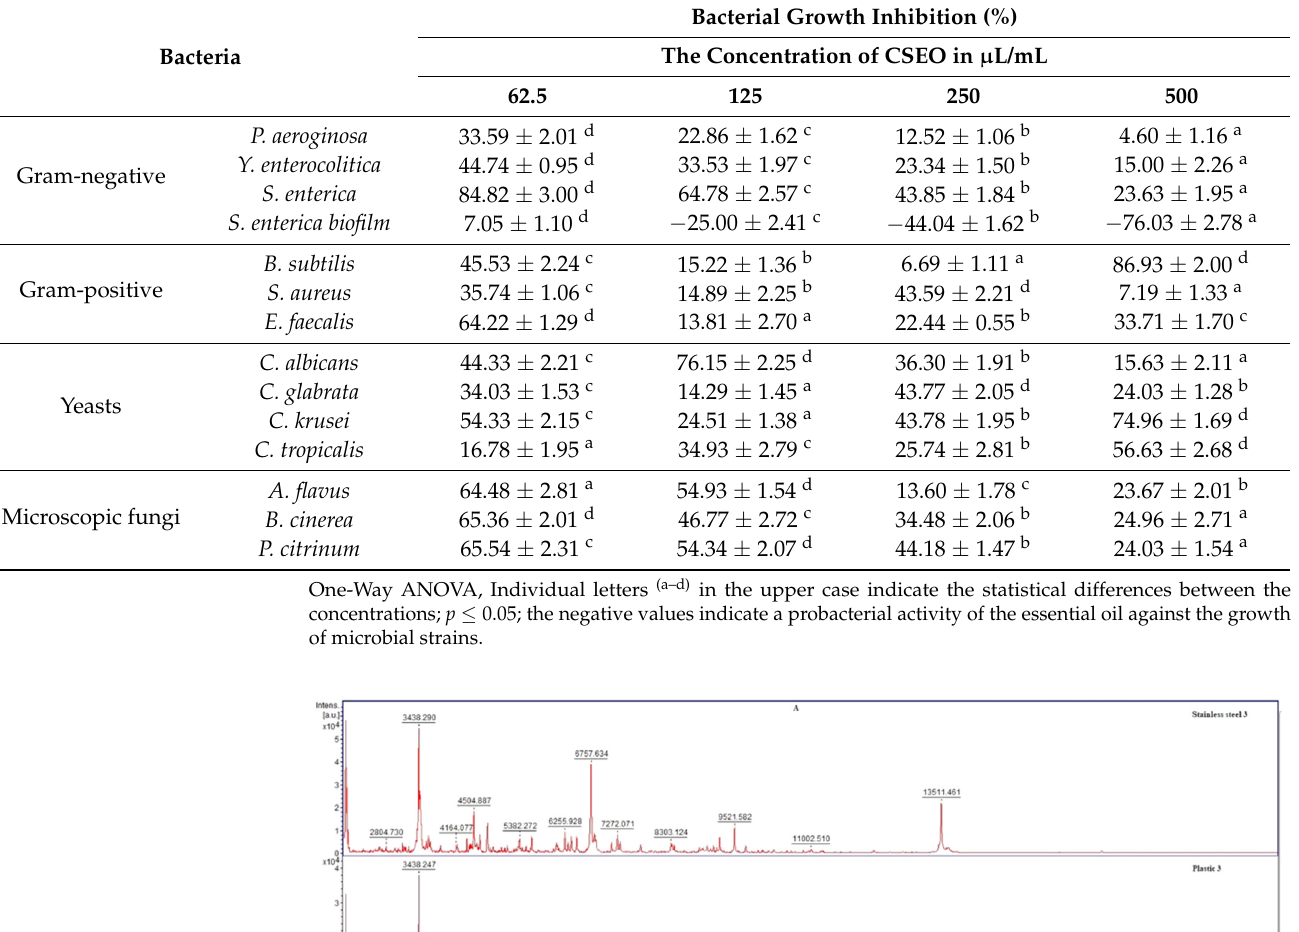
Bacterial Growth Inhibition